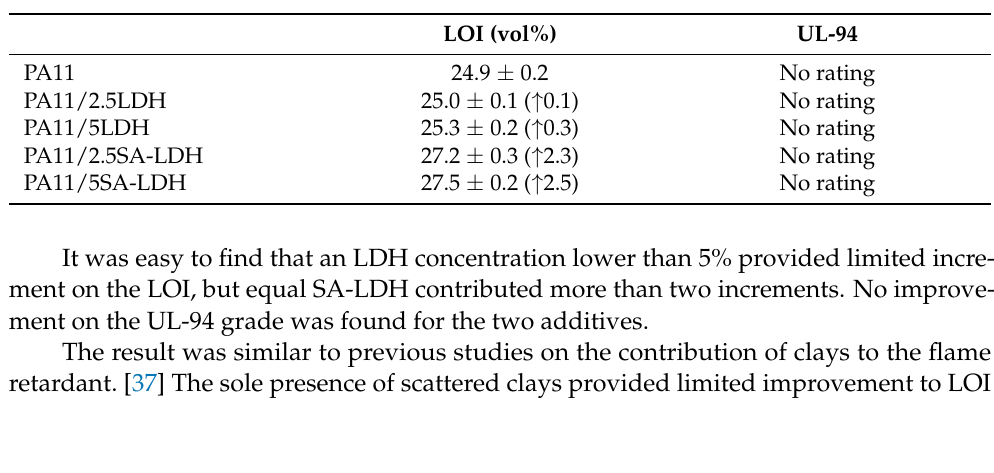
Table 2. LOI and UL-94 results for PA11 and its